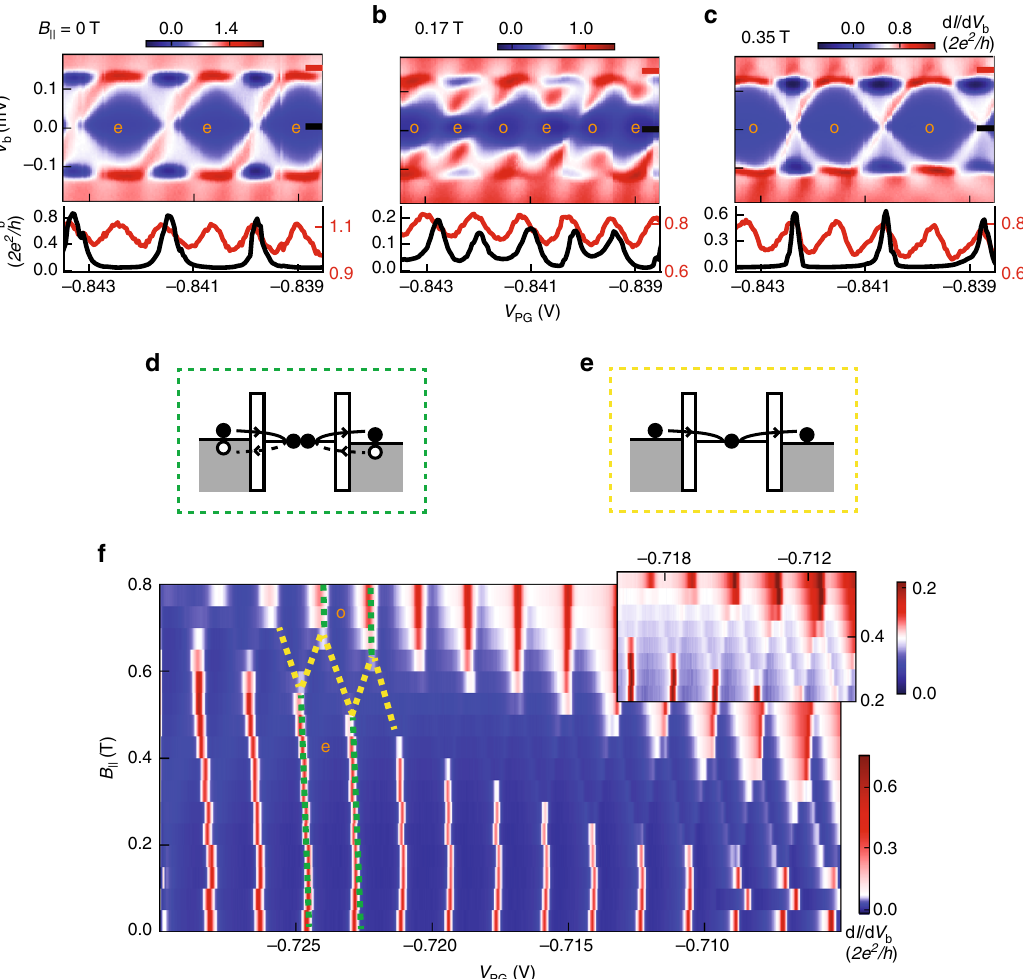
Fig. 3 Transport via an odd-parity GS. ( a – c ) Coulomb diamonds for the gate settings in Fig. 2b at different B ∥ . Below are linecuts at V b = 0 (black trace) and V = 150 μ V (red trace), respectively. f Another example of an even-to-odd GS transition. The inset is a zoom-in of the even – odd regime with a different b scale bar. The sketch in d illustrates the Cooper pair tunnelling process in both even- and odd-GS regimes (marked by green dashed lines in f ), while e illustrates the single electron tunnelling process in the alternating even – odd parity GS regime (marked by yellow dashed lines in f